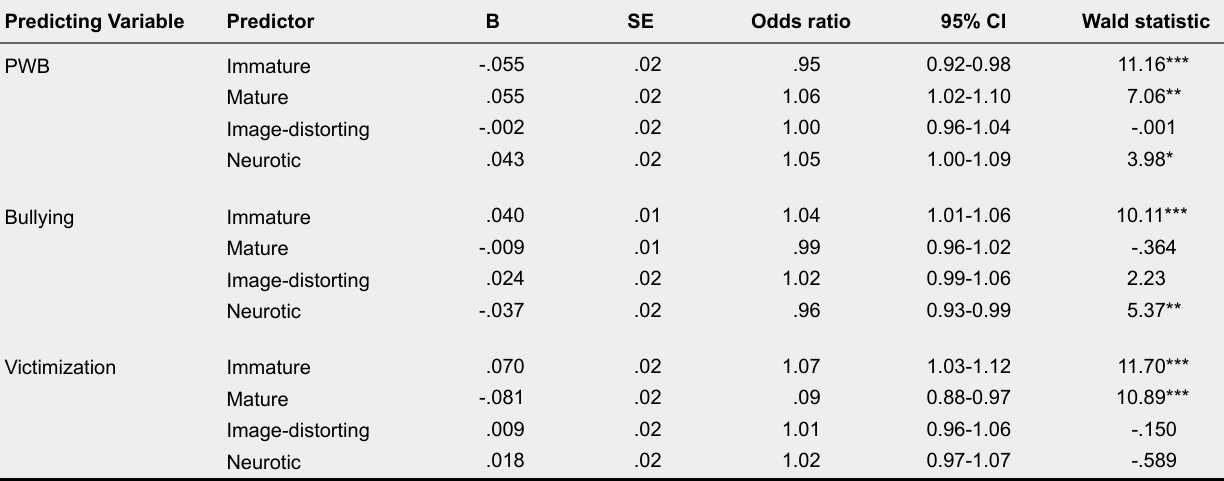
Logistic Regressions for the Prediction of Psychological Well-Being (PWB), Bullying and Victimization From DSQ-40 Sub-Scales Predicting